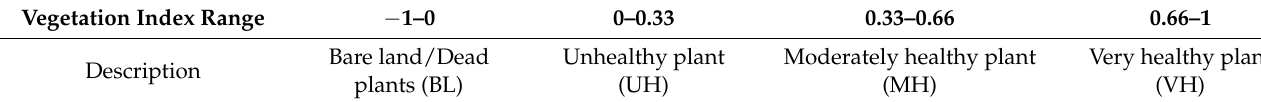
Table 2. Stand health classification of Miscanthus from reclassified vegetation indices (VIs: NDVI, NDRE, and GNDVI) obtained during UAV flights in the 2018 and 2019 growing season in Urbana, IL, USA.